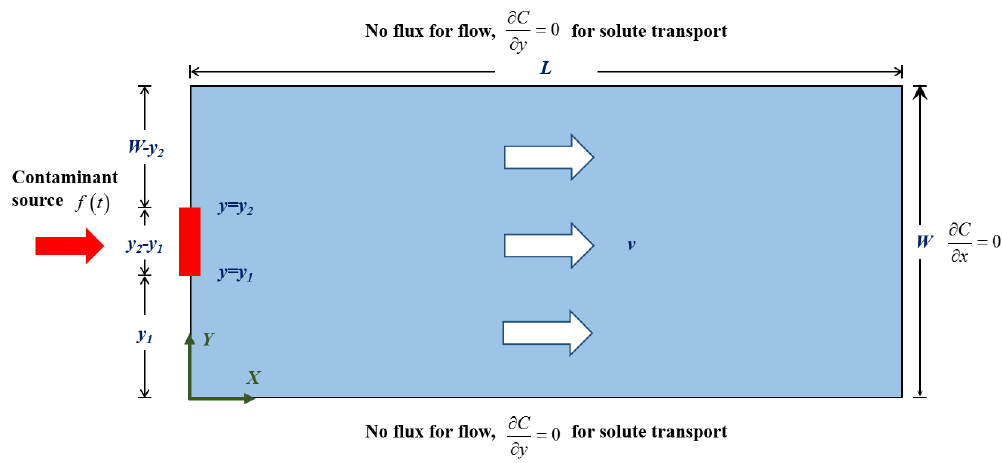
Figure 1. Schematic representation of two-dimensional transport of decaying contaminants in a uniform flow field with flux boundary source located at of the inlet boundary.